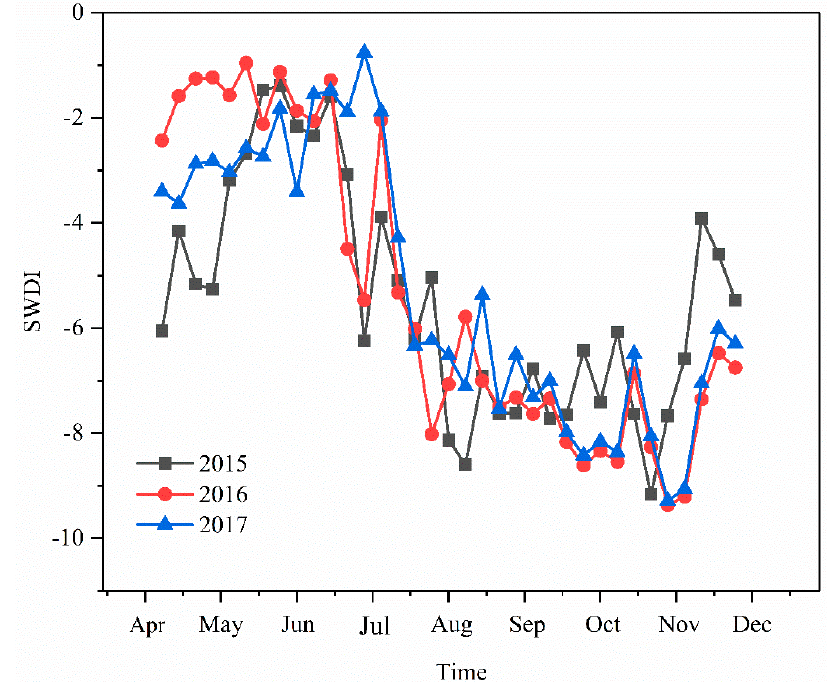
Figure 4. Weekly time series of SMAP_SWDI in the Xiang River Basin.